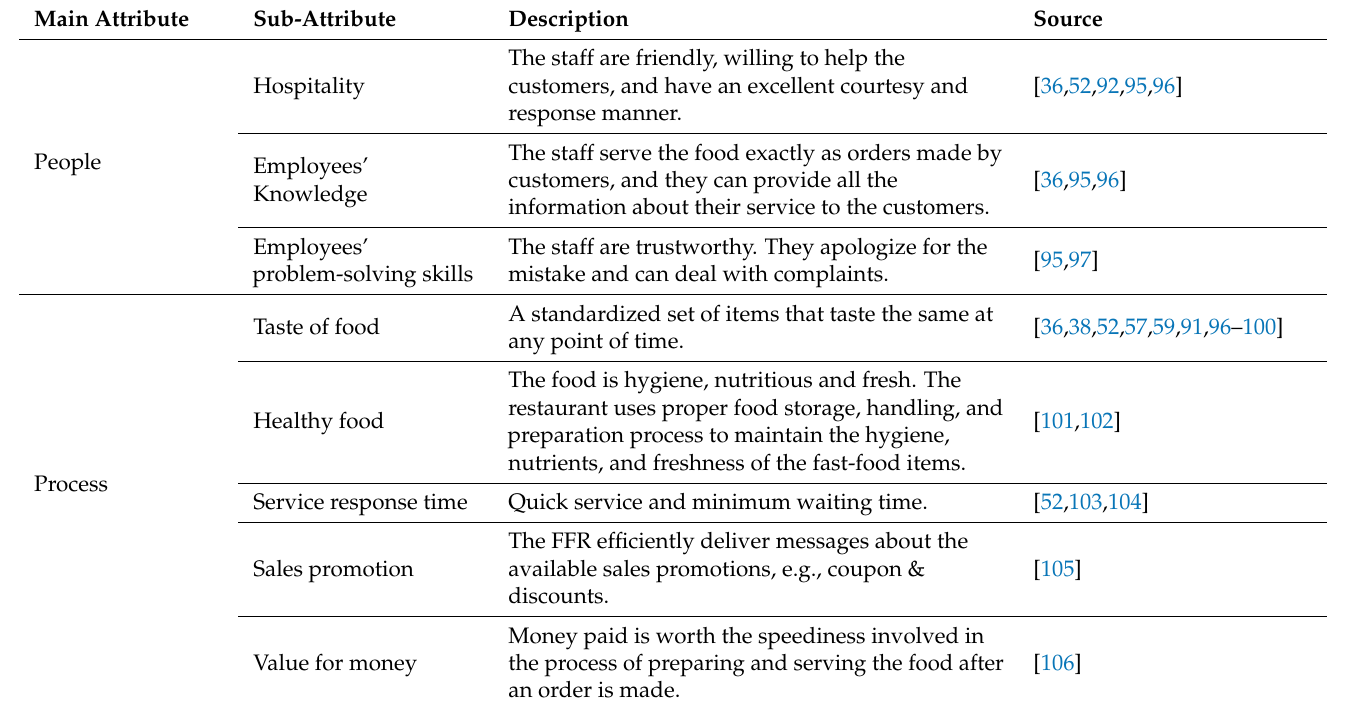
Table 4. List of sub-attributes extracted from past literature. Main Attribute Sub-Attribute